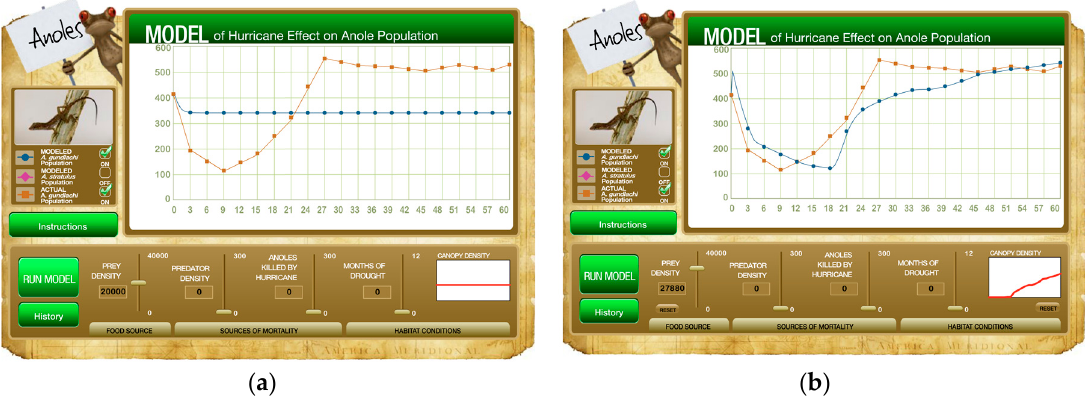
Figure 4. Screenshots of the process of modeling population data. ( a ) The student has run the model without changing any of the input parameters. ( b ) The student has increased the availability of prey and has drawn the canopy to reflect the total loss of canopy after the hurricane and gradual return over a 5-year period.